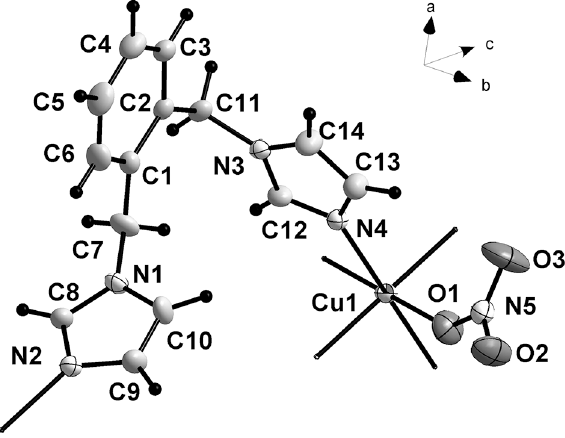
Table 1 contains crystallographic data and Table 2 contains the list of the atoms including atomic coordinates and displacement parameters.